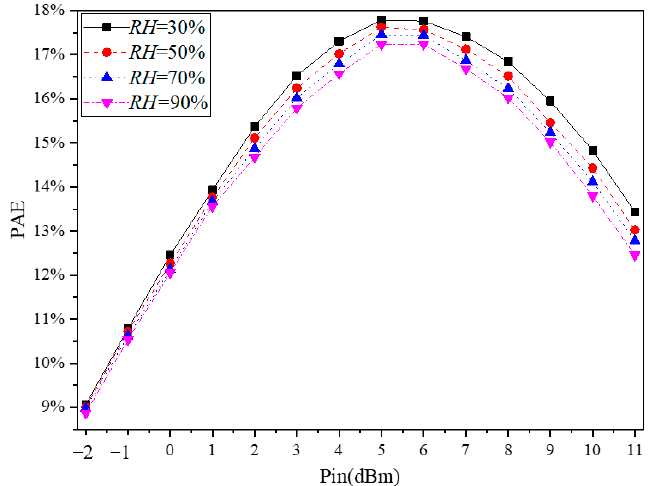
Figure 8. Measured PAE vs. humidity at 433 MHz.